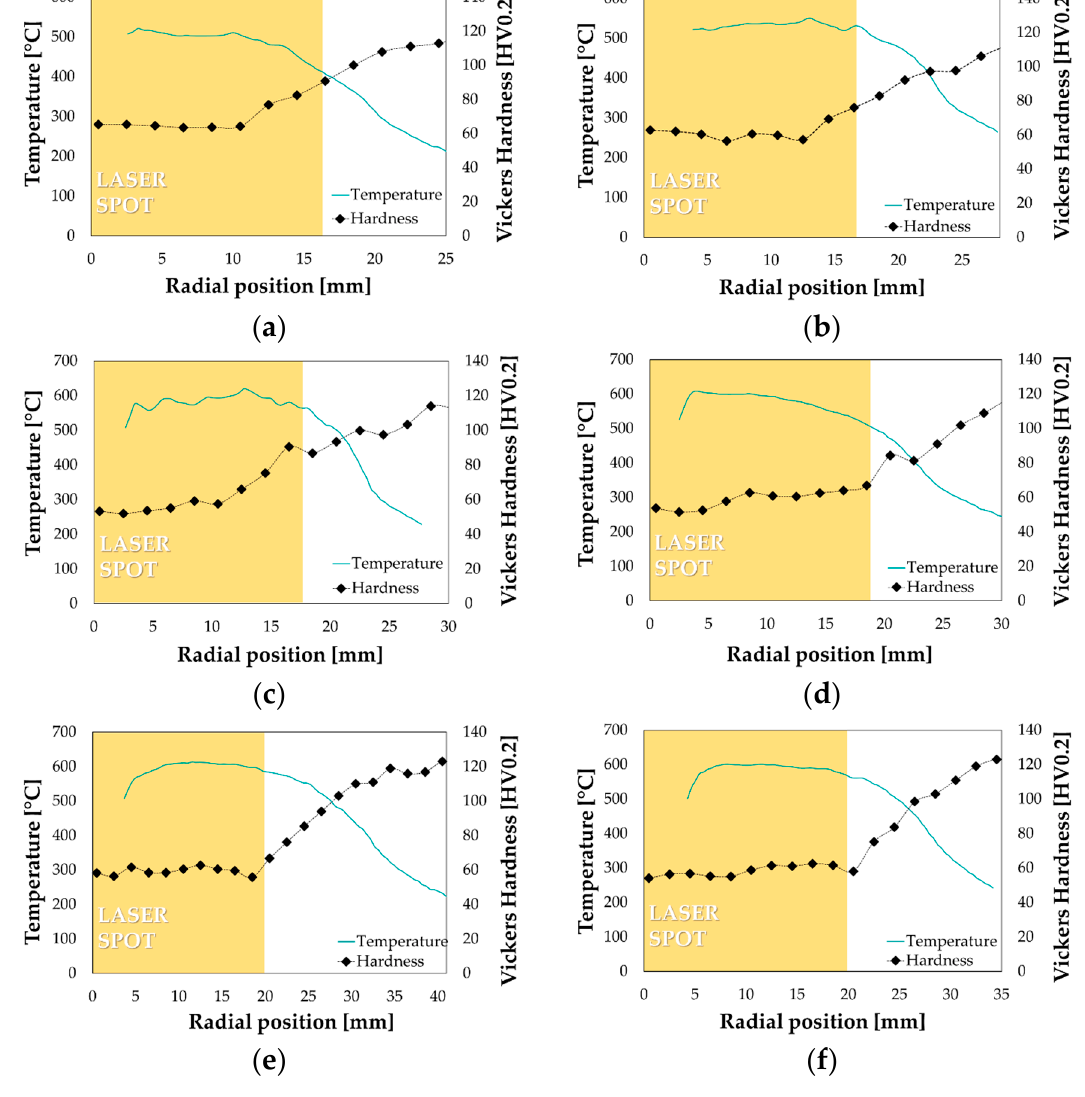
Figure 24. Temperature distribution and hardness measurement after LHT: ( a ) D = 102 mm, ( b ) D = 104 mm, ( c ) D = 106 mm, ( d ) D = 108 mm, ( e ) D = 112 mm, ( f ) D = 114 mm.